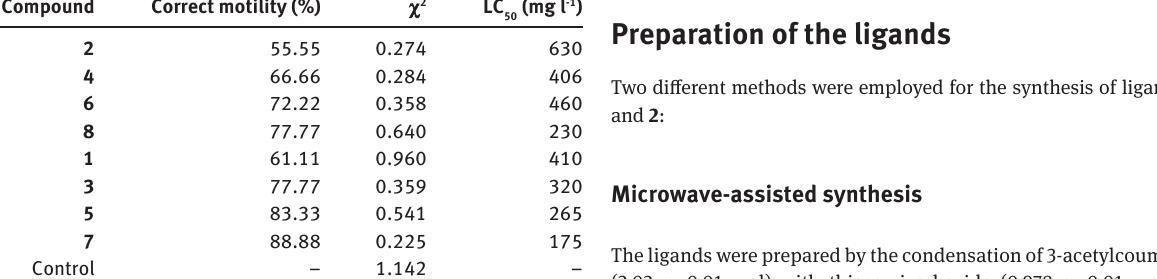
Table 4 Pesticidal data of the ligands and their metal complexes.